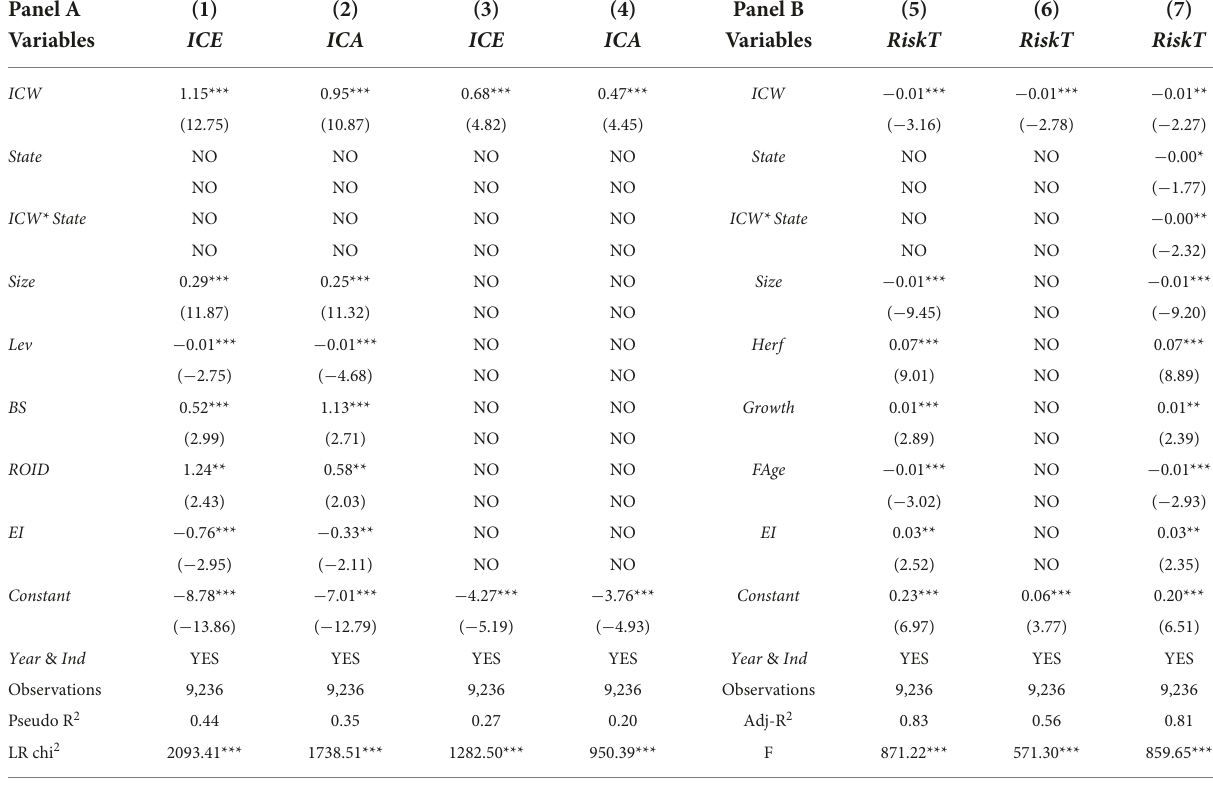
TABLE 3 Regression results of test model.